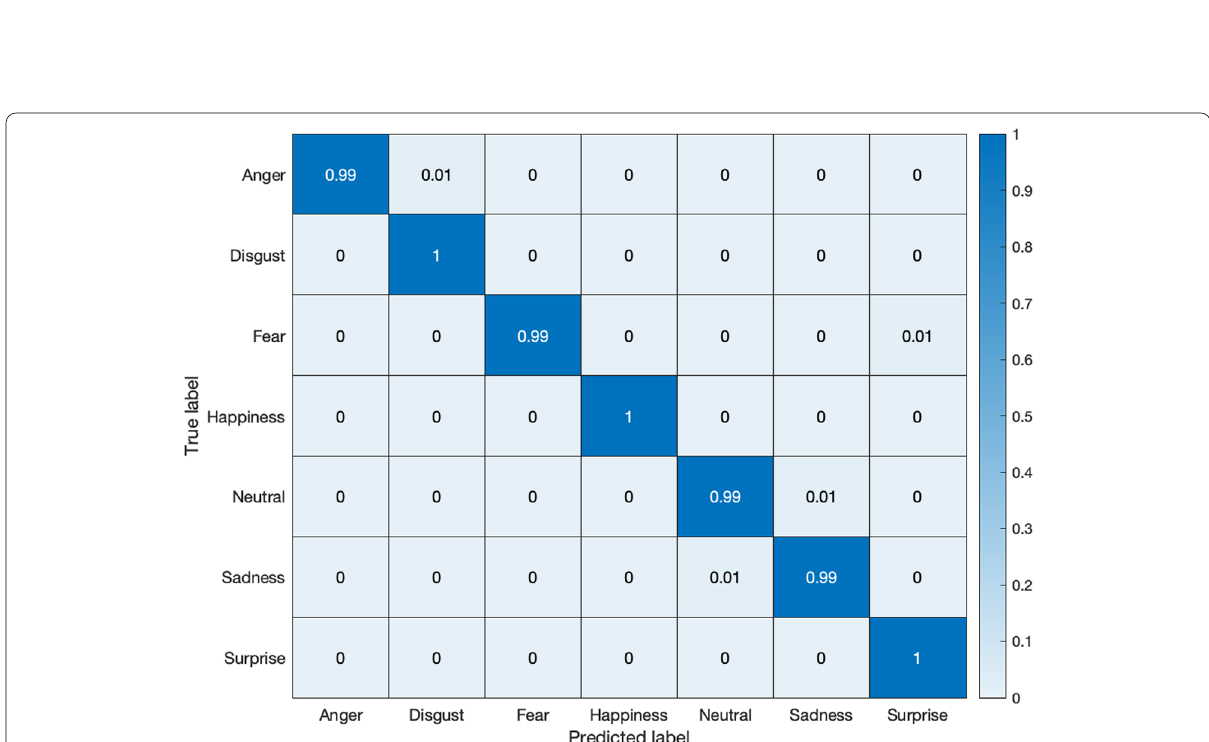
Fig. 15 Confusion matrix of facial expressions in CK